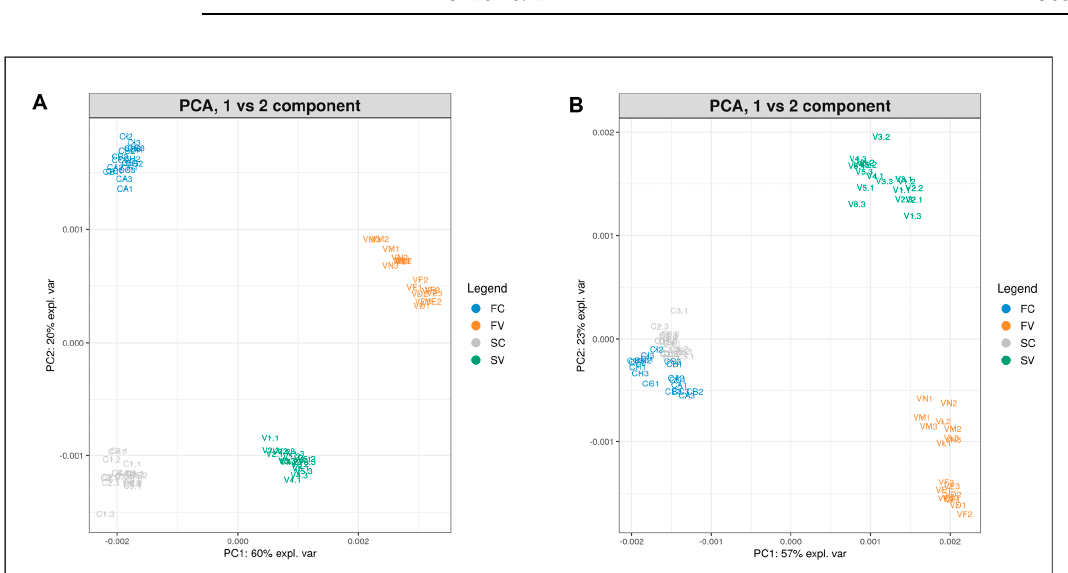
Figure 8. PCA plot (PC1 vs. PC2) of albumin ( A ) and globulin ( B ) extracts from Finola certified seeds (FC, blue), Finola harvested seeds from Viganella (FV, orange), Secuieni J. certified seeds (SC, gray) and Secuieni J. harvested seeds from the experimental field of Viganella (SV, green). Hierarchical clustering analysis (HCA) was performed to visualize the clustering of mass spectra. The two dendrograms generated using the data from seeds of different cul- tivar and origin are depicted in Figure 9. A clear distinction according to plant cultivar and seed origin is visible for both albumin and globulin extracts. The first ramification divides the samples obtained from the Viganella site and samples from certified seeds. Then, within each of these two groups, a second branching separates samples of Finola and Secuieni J. into two distinct clusters, formed by samples of the same type.